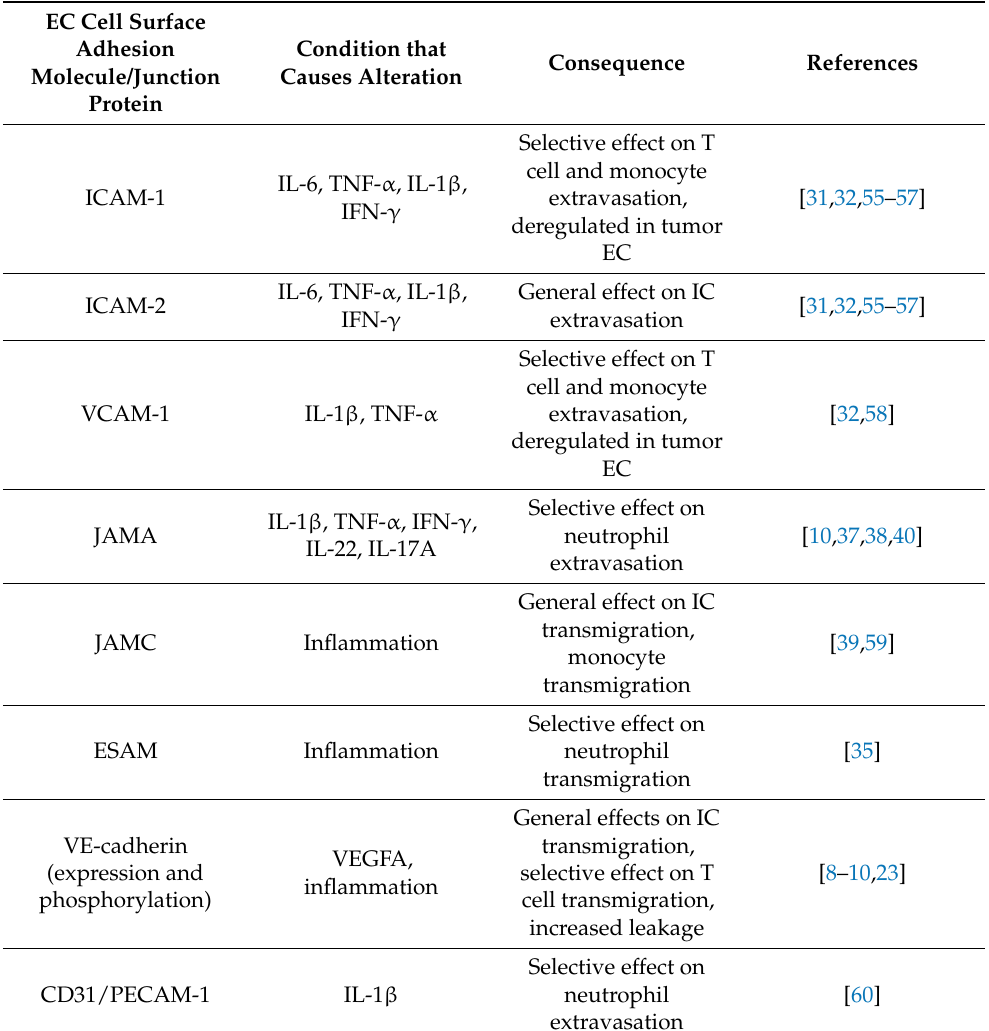
Table 1. Cont. EC Cell